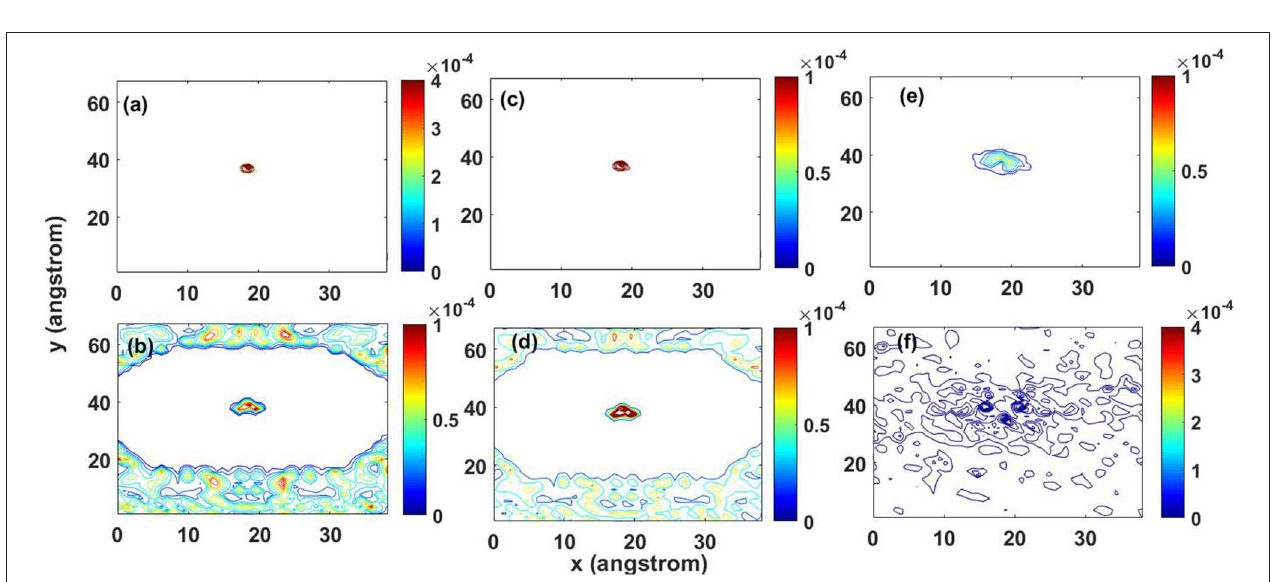
FIGURE 7 | Contour lines of kinetic energy distribution: (a) harmonic potential at 0.02 ps, (b) harmonic potential at 0.28 ps, (c) anharmonic potential at 0.02 ps, (d) anharmonic potential at 0.28 ps, (e) Tersoff potential at 0.02 ps, and (f) Tersoff potential at 0.28